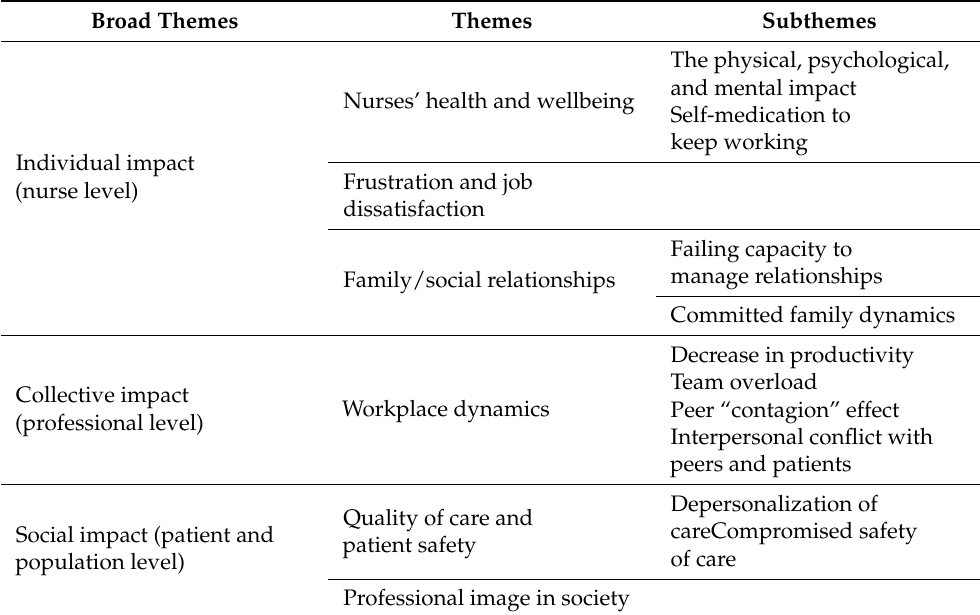
Table 2. The consequences of presenteeism evoked by frontline nurses and nurse managers in both